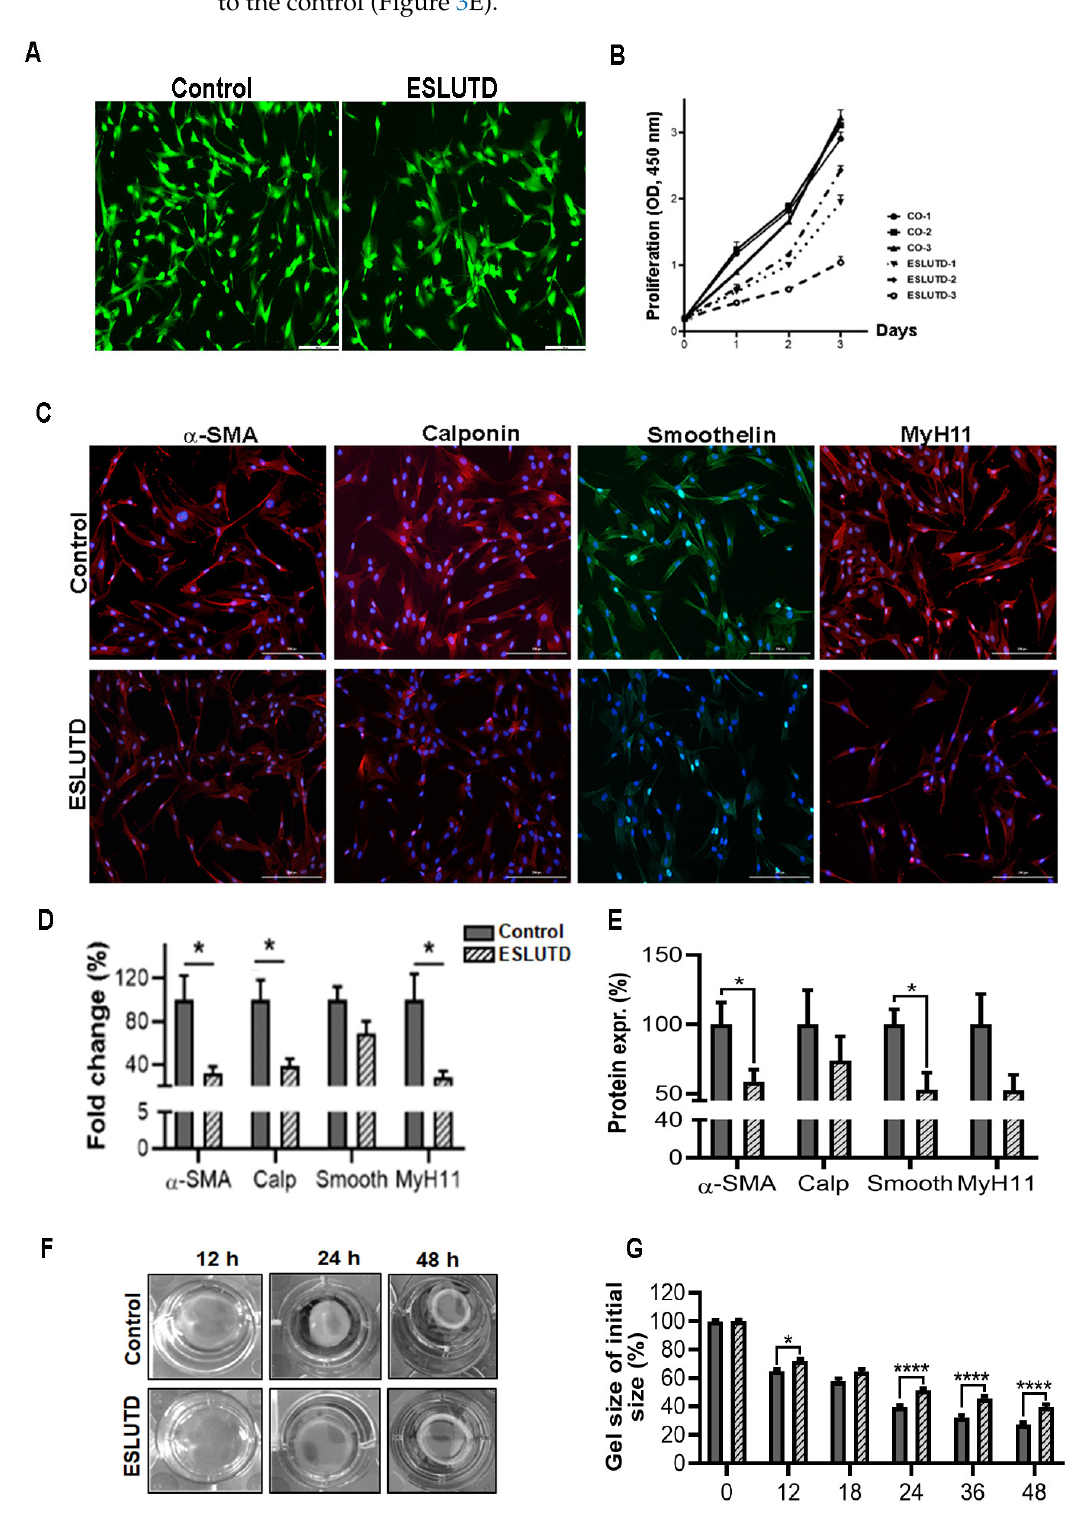
Figure 3. Assessment of contractile phenotype in hSMCs isolated from control and ESLUTD bladders. ( A ) Microscopic images of hSMCs stained with Calcein AM. Green staining indicates viable cells. Both groups showed an equivalent number of viable cells. Scale bar, 200 μ m. ( B ) Cell proliferation rate of control and ESLUTD hSMCs. Control hSMCs had a higher proliferation rate